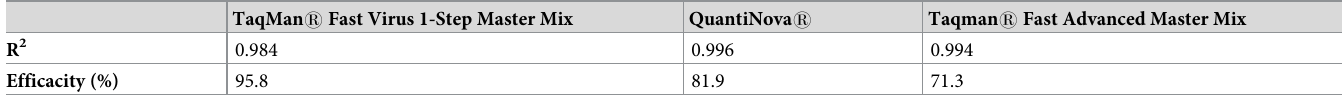
Table 1. Comparison of R 2 and efficiency between various enzymatic mixes.